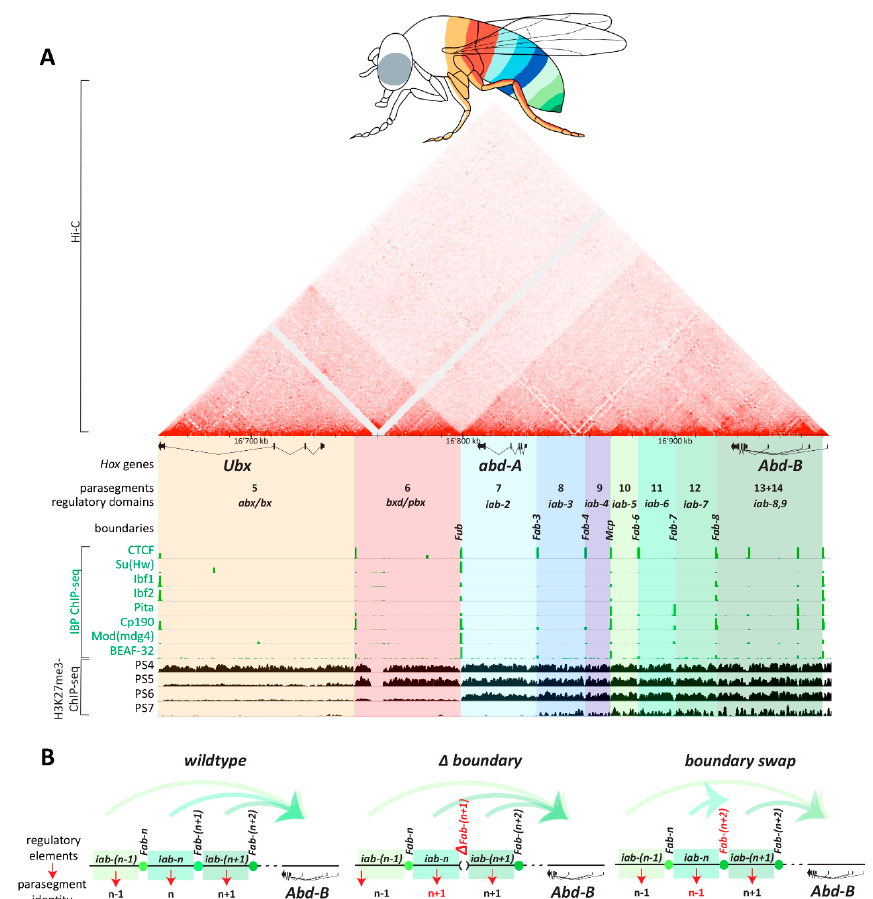
Figure 6. The importance of fly insulators in Hox gene expression. ( A ) Map (dm6 coordinates indicated) of the bithorax complex (BX-C) in Drosophila melanogaster containing the Ultrabithorax ( Ubx ), abdominal-A ( abd-A ) and Abdominal-B ( Abd-B ) genes (rectangles indicate exons, connecting lines indicate splice junctions, and arrowheads point in the direction of transcription). Genetically-identified regulatory domains (colored) driving expression of a Hox gene in a specific body parasegment and the boundaries between these domains are indicated. Published chromatin immunoprecipitation (ChIP)-seq tracks [23,24,149 – 151] of several IBPs shows colocalization with boundaries. Parasegment-specific H3K27me3 profiles show domain-wide loss of H3K27me3 in body segments in which a respective regulatory domain is active [38]. A Hi-C map generated in Kc cells [89] (Top) show that some regulatory domains correspond to TADs, with a very clear separation of Ubx regulatory regions from abd-A and Abd-B regulatory regions. ( B ) Summary of genetic boundary deletion and swapping experiments, using generic Abd-B boundaries as examples ( Fab-n depicts the boundary between iab-(n - 1) and iab-n regulatory domains that pattern body segments n-1 and n, respectively). (Middle) When a boundary is deleted, enhancing activities of the two formerly insulated regulatory domains mix, and segment n transforms its identity to that of segment n + 1 (regulatory domains are thought to act in an additive fashion [152]). (Right) When a boundary is swapped for a heterologous insulator (in this example, for the next boundary Fab-(n + 2) ), the flanking regulatory domains remain insulated, but the preceding regulatory domain is typically no longer able to bypass the heterologous boundary. This leads to the transformation of the identity of segment n to that of n − 1.